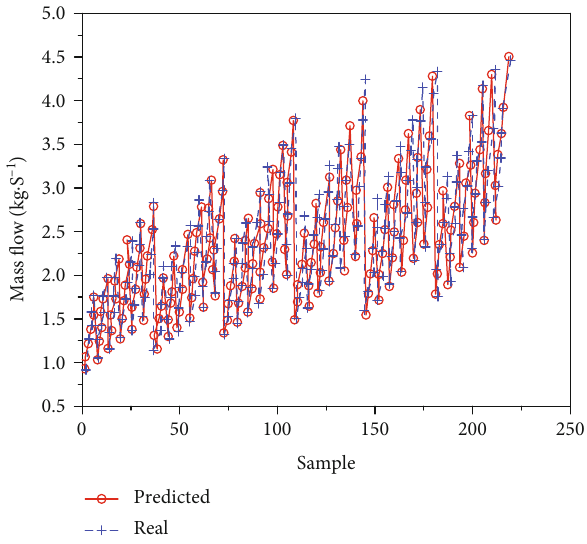
Figure 11: Comparison of predicted and calculated values of the mass fl ow rate. Table 6: Performance before and after